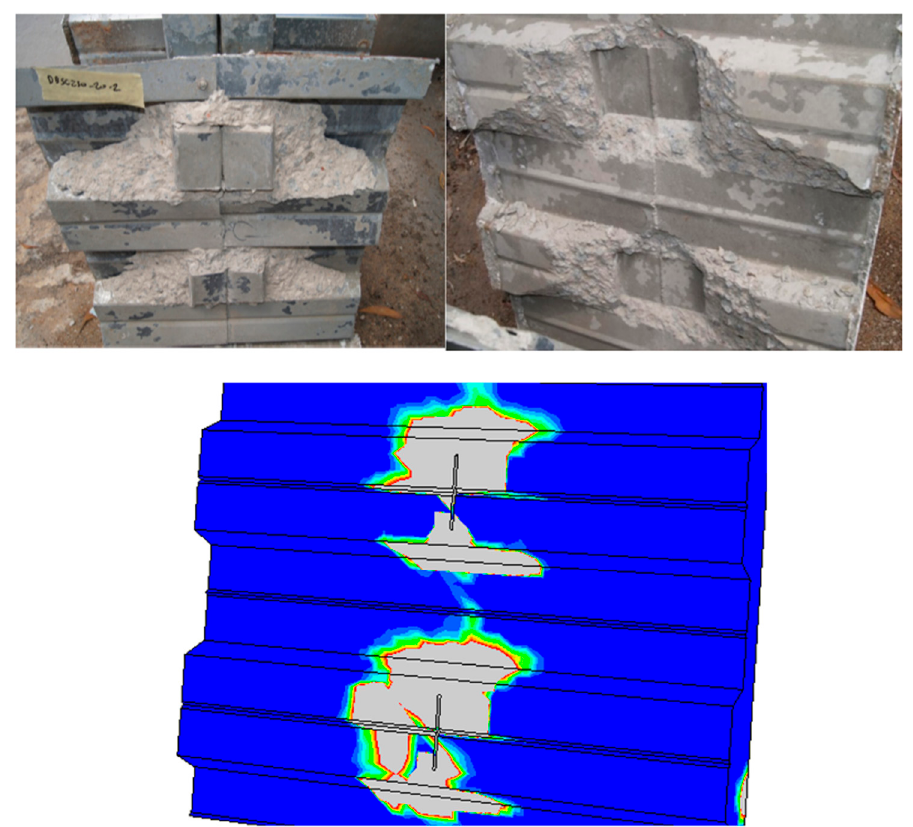
Figure 8. Failure mode of the DBSC test specimen compared to the proposed FE model.